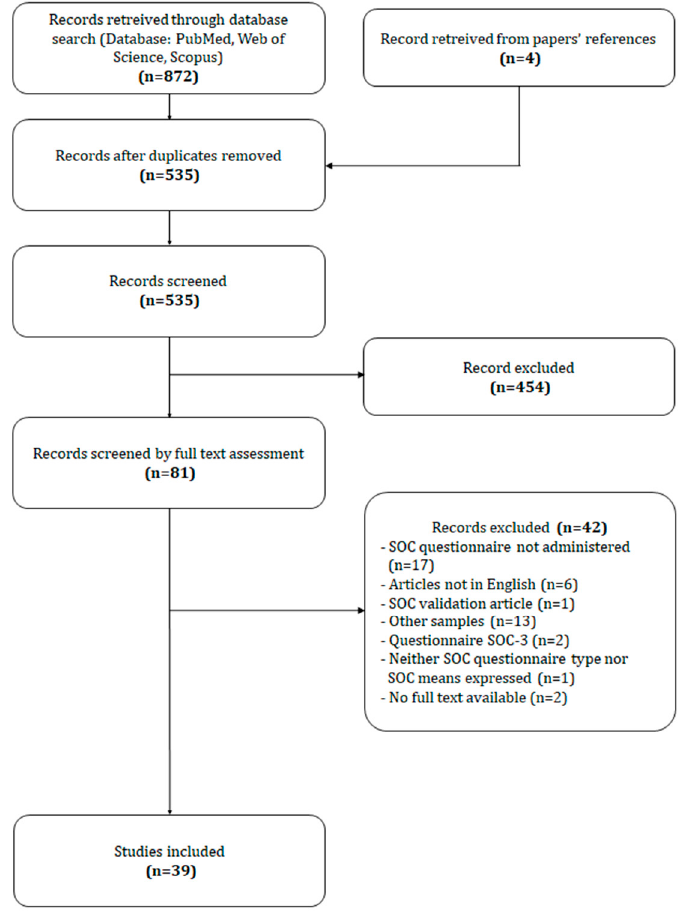
Figure 1. Flowchart of the searching and screening of literatures.